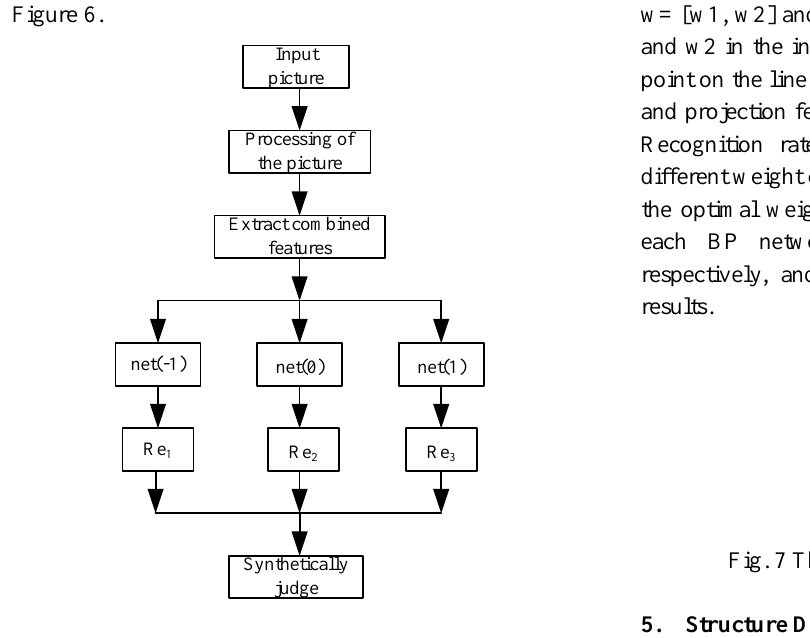
Fig. 6 The flow of recognition algorithm